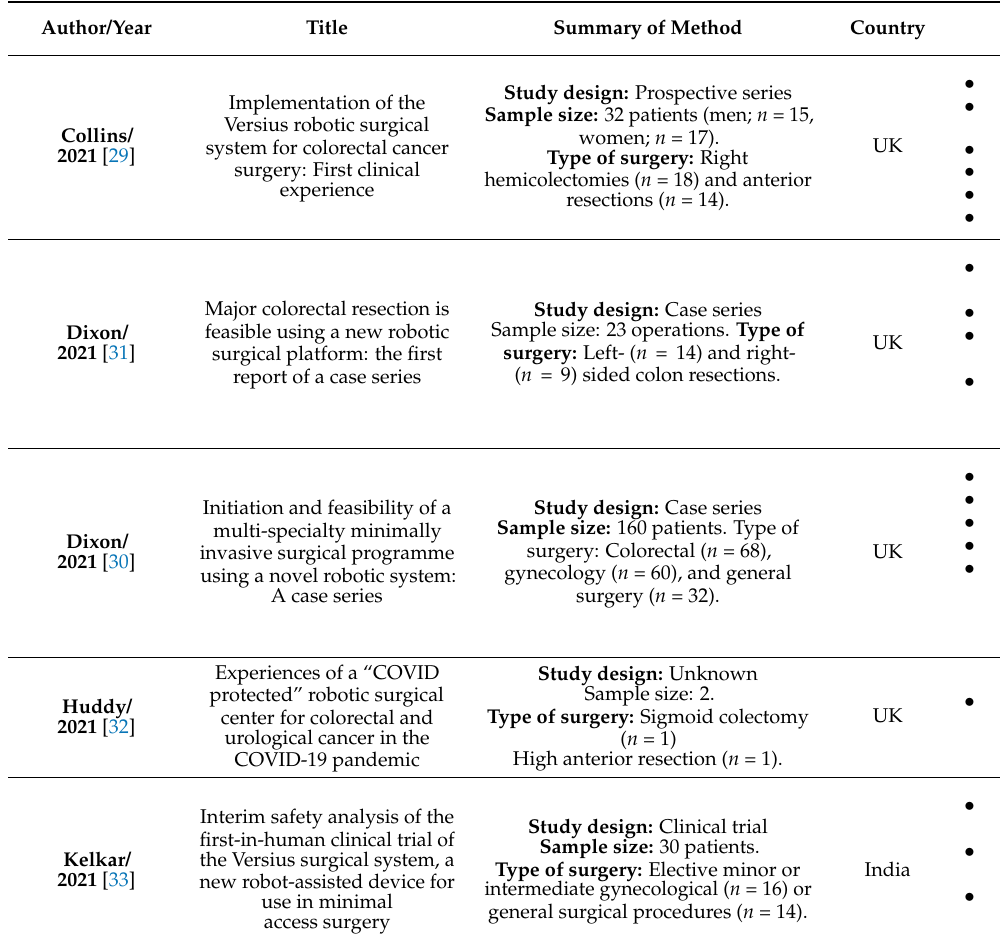
Table 4. Clinical effectiveness of the Versius system in minimal access